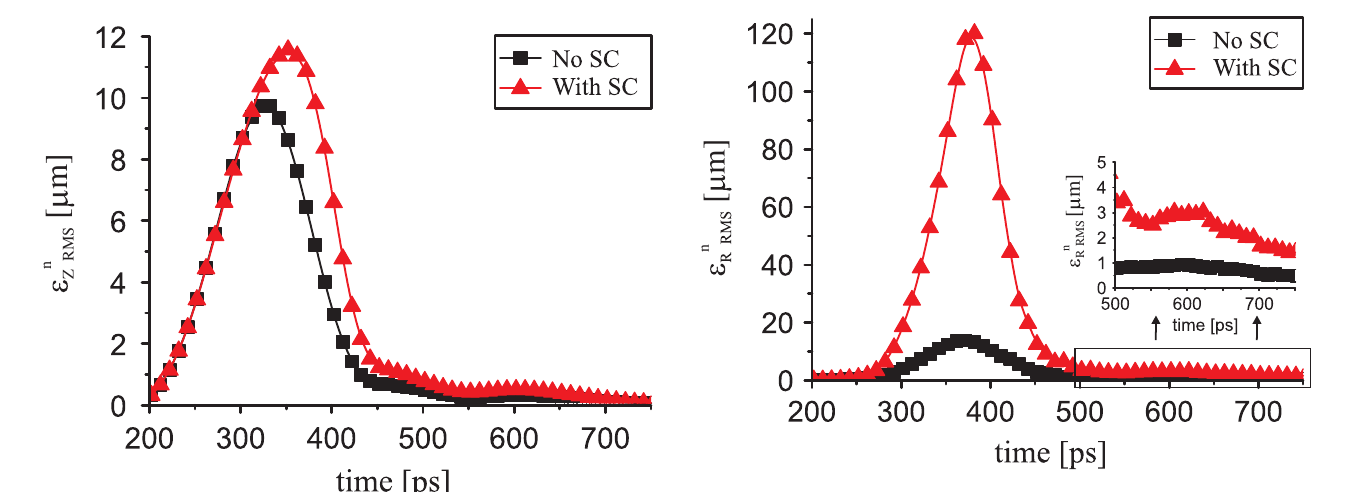
FIG. 16. (Color) Time evolution of the normalized RMS emit- ) with and without taking tance in the transverse direction ( " N R RMS ) with and without the effects of space charge into account. The inset is an enlarge- Z RMS ment of the final part of the evolution.